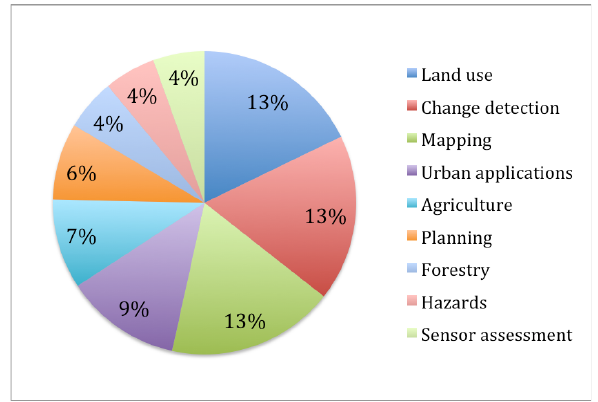
Figure 5b. Applications based on the